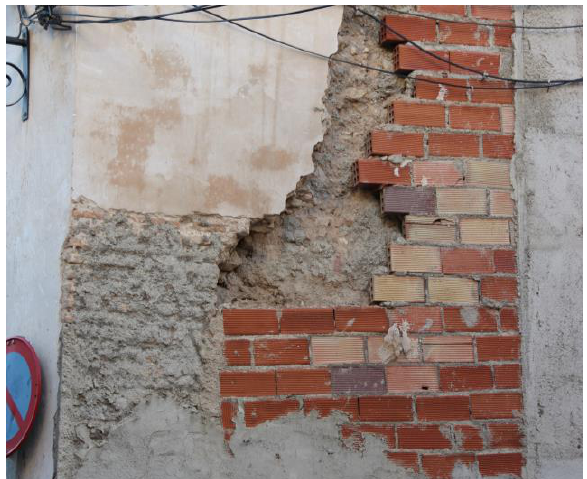
Figure 17. Hollow brick layer added to a rammed earth wall (Source: